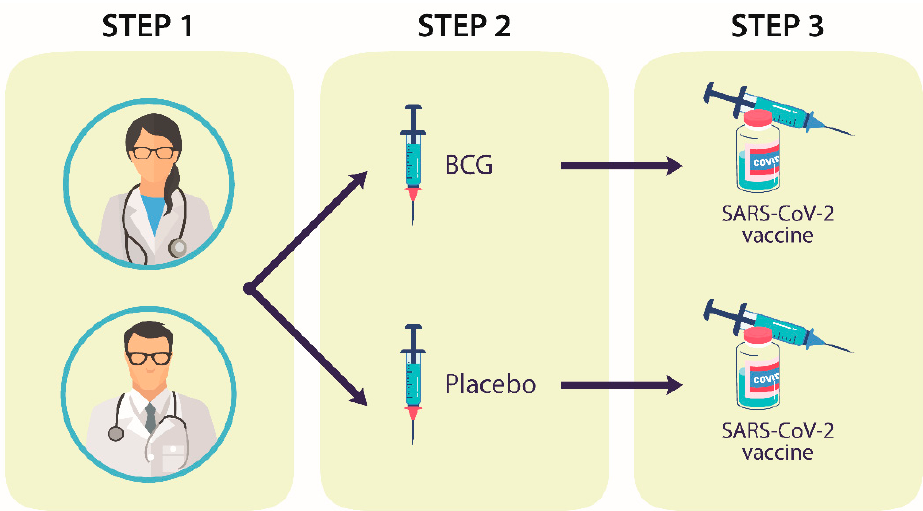
Figure 1. Graphic diagram of the study. Step one: sixty participants who had been occupationally exposed to SARS-CoV-2 were enrolled. Step two : two groups of 30 participants were randomly integrated; one group received a BCG vaccine, whereas the other group received a placebo. At the end of this step, the serum concentrations of pro-inflammatory cytokines were determined. Step three : both groups of participants received the Pfizer–BioNTech vaccine. At the end of this period, serum concentrations of pro-inflammatory cytokines and neutralizing antibodies were determined. Twelve HLA alleles were also genotyped.